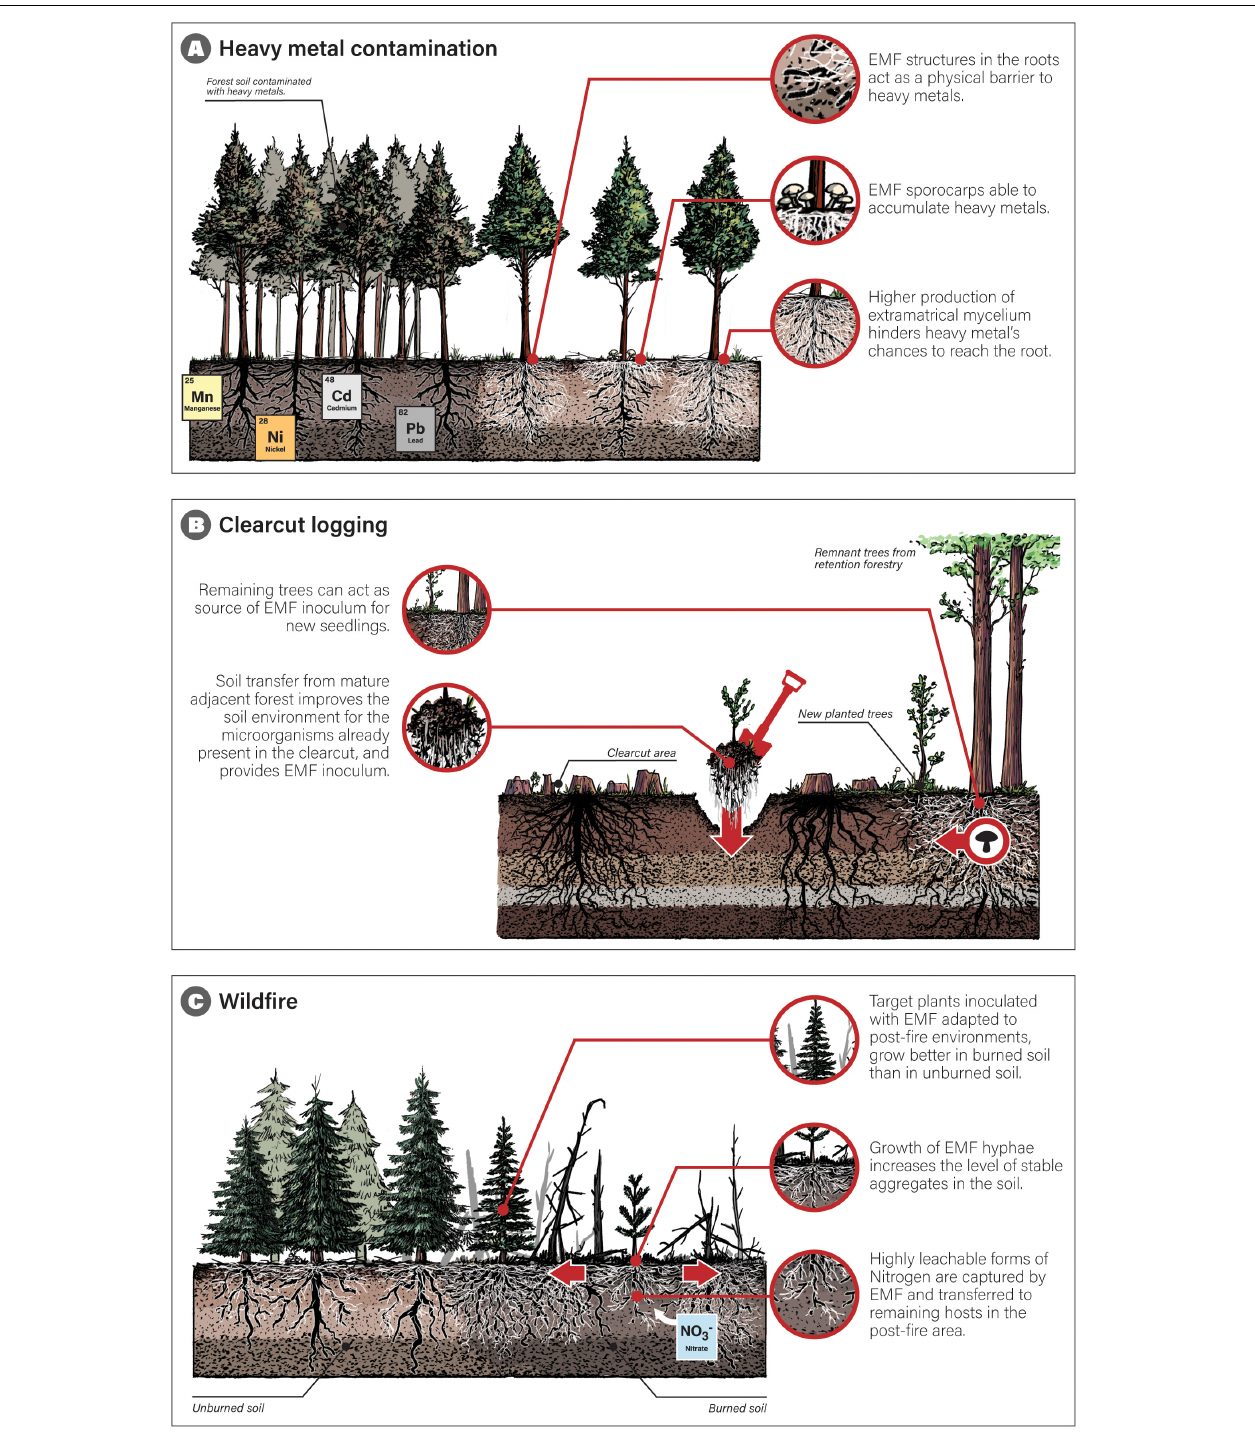
FIGURE 1 | Three different scenarios of temperate or boreal forest degradation and suggested modes of restoration that consider the use of ectomycorrhizal fungi (EMF). In panel (A) , specific host trees associated with heavy metal tolerant EMF are planted in forest soil contaminated with heavy metals. In panel (B) , retention forestry is presented as an alternative to clearcut logging, in which groups of mature trees are left intact and are able to offer new planted trees access to the existing mycorrhizal network, favoring establishment. Soil translocation from adjacent forest is a complementary option to improve soil conditions in the clearcut area. In panel (C) , EMF inoculated plants are planted in the post fire area. EMF traits help increase hosts’ growth, soil aggregates’ stability, and nutrients’ transfer to other hosts nearby.